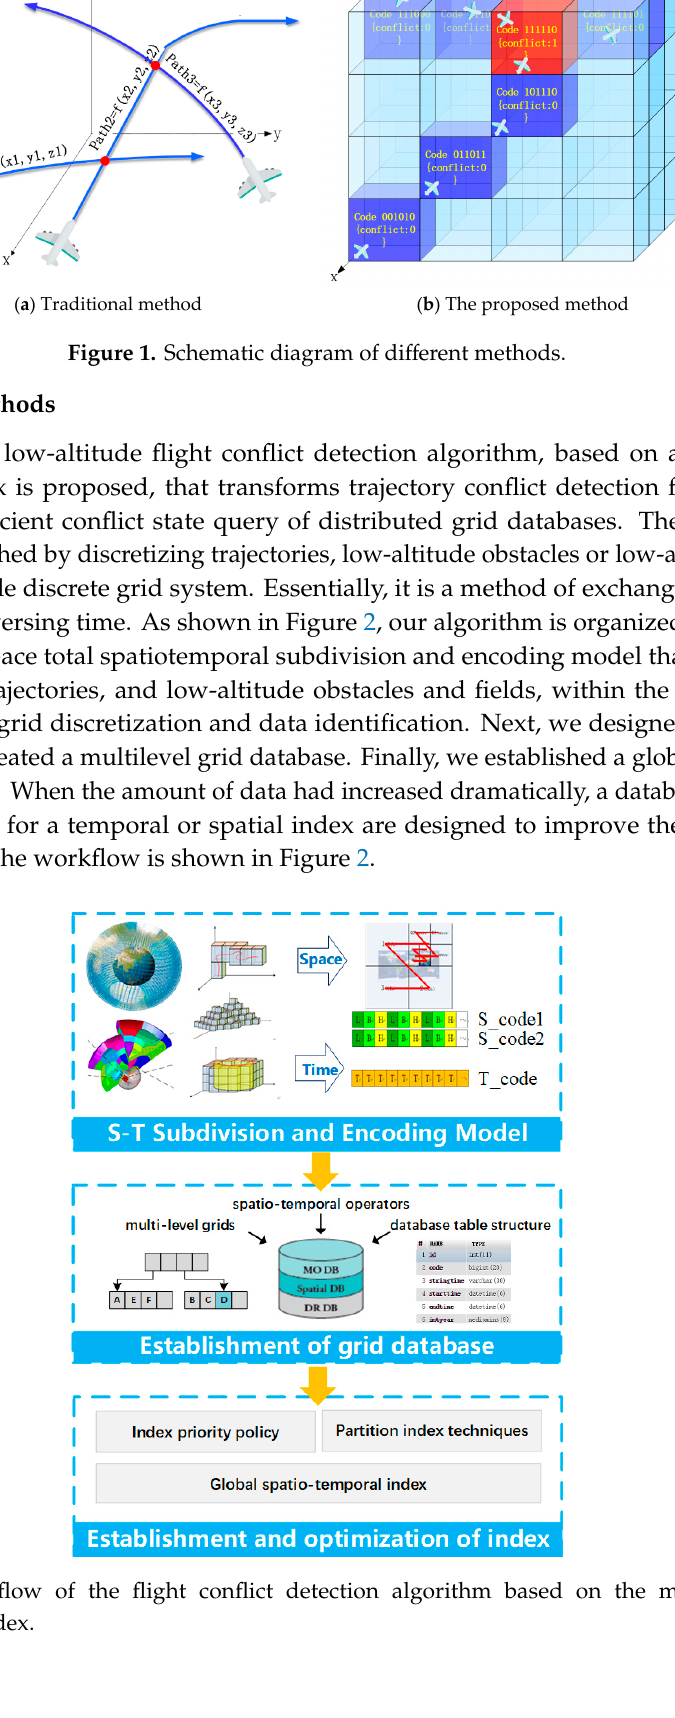
Figure 2. Workflow of the flight conflict detection algorithm based on the multilevel grid spatiotemporal index. In this paper, a low-altitude flight conflict detection algorithm, based on a multi-level grid spatiotemporal index is proposed, that transforms trajectory conflict detection from multivariate solutions into an efficient conflict state query of distributed grid databases. The distributed grid databases are established by discretizing trajectories, low-altitude obstacles or low-altitude dangerous fields into a multiscale discrete grid system. Essentially, it is a method of exchanging grid database storage space for traversing time. As shown in Figure 2, our algorithm is organized as follows. First, we built a flight airspace total spatiotemporal subdivision and encoding model that subdivides and encodes the flight trajectories, and low-altitude obstacles and fields, within the flight airspace to achieve a multilevel grid discretization and data identification. Next, we designed a grid database table structure and created a multilevel grid database. Finally, we established a global multiscale grid spatiotemporal index. When the amount of data had increased dramatically, a